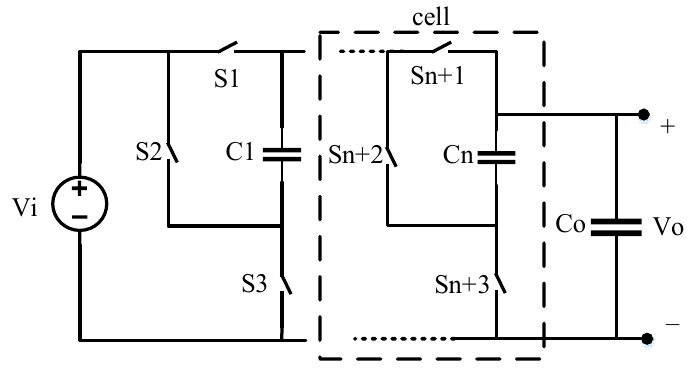
Figure 7. FC. Figure 7.